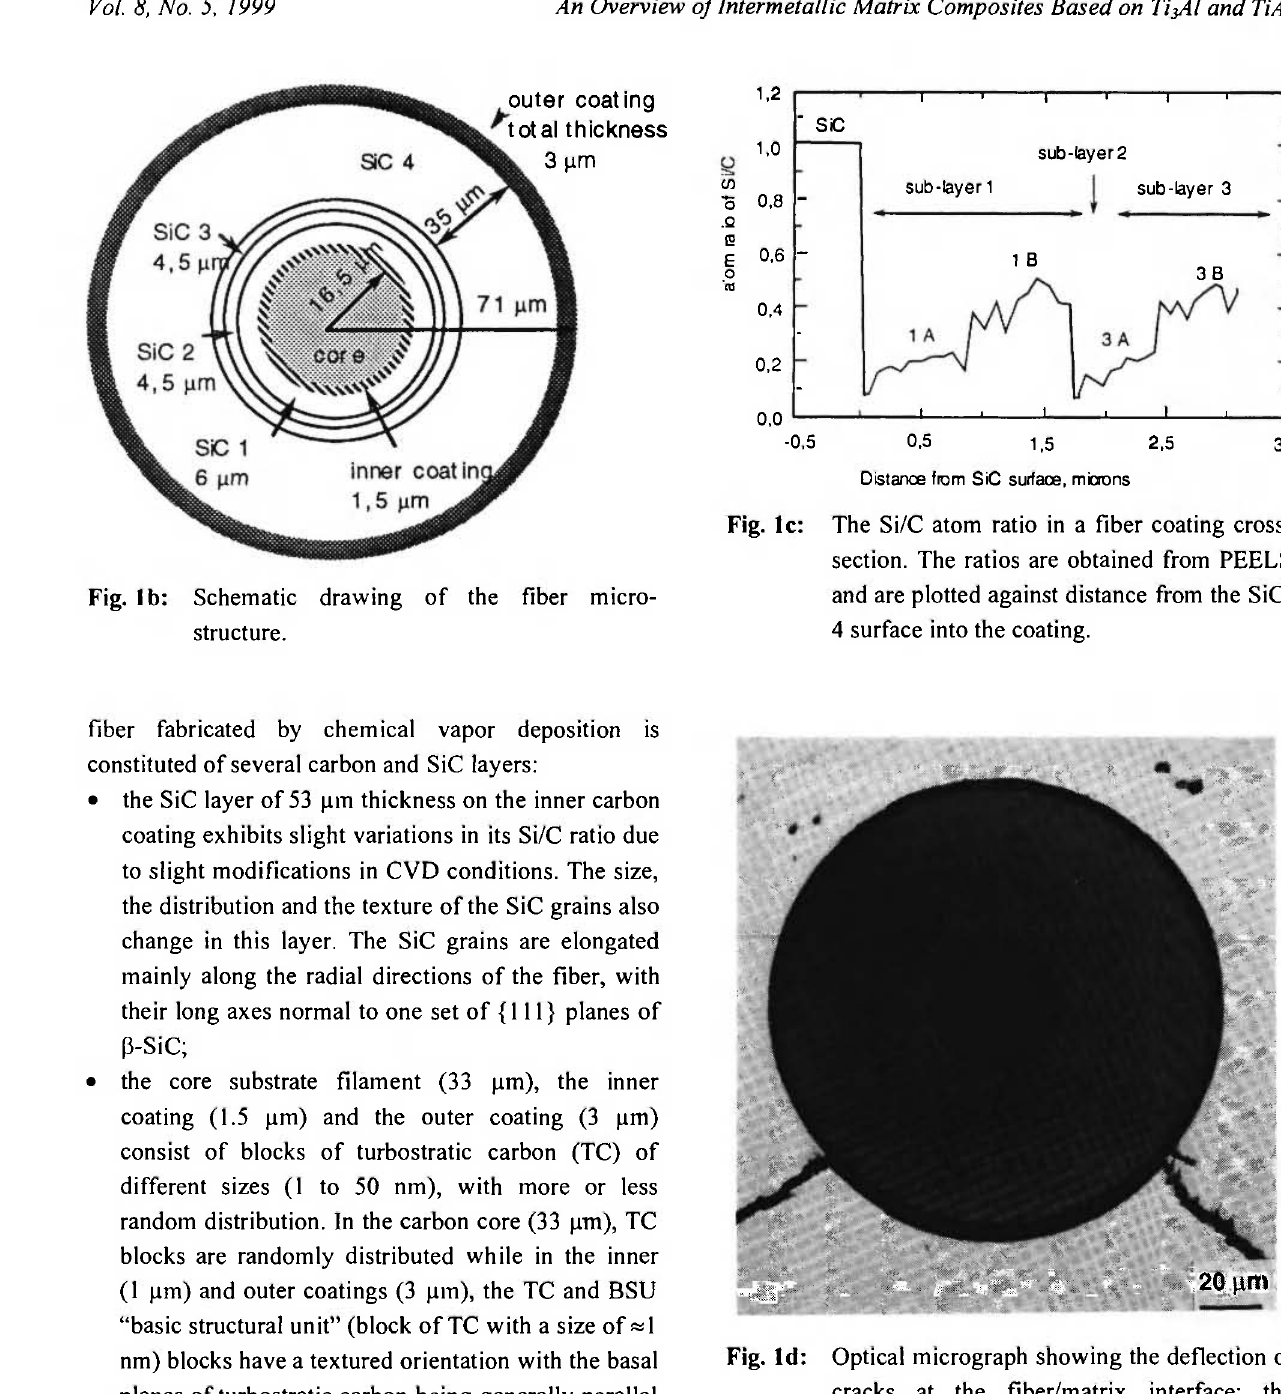
• • ν· Fig. Id: Optical micrograph showing the deflection of cracks at the fiber/matrix interface; the carbon layer ensures the role of mechanical fuse.